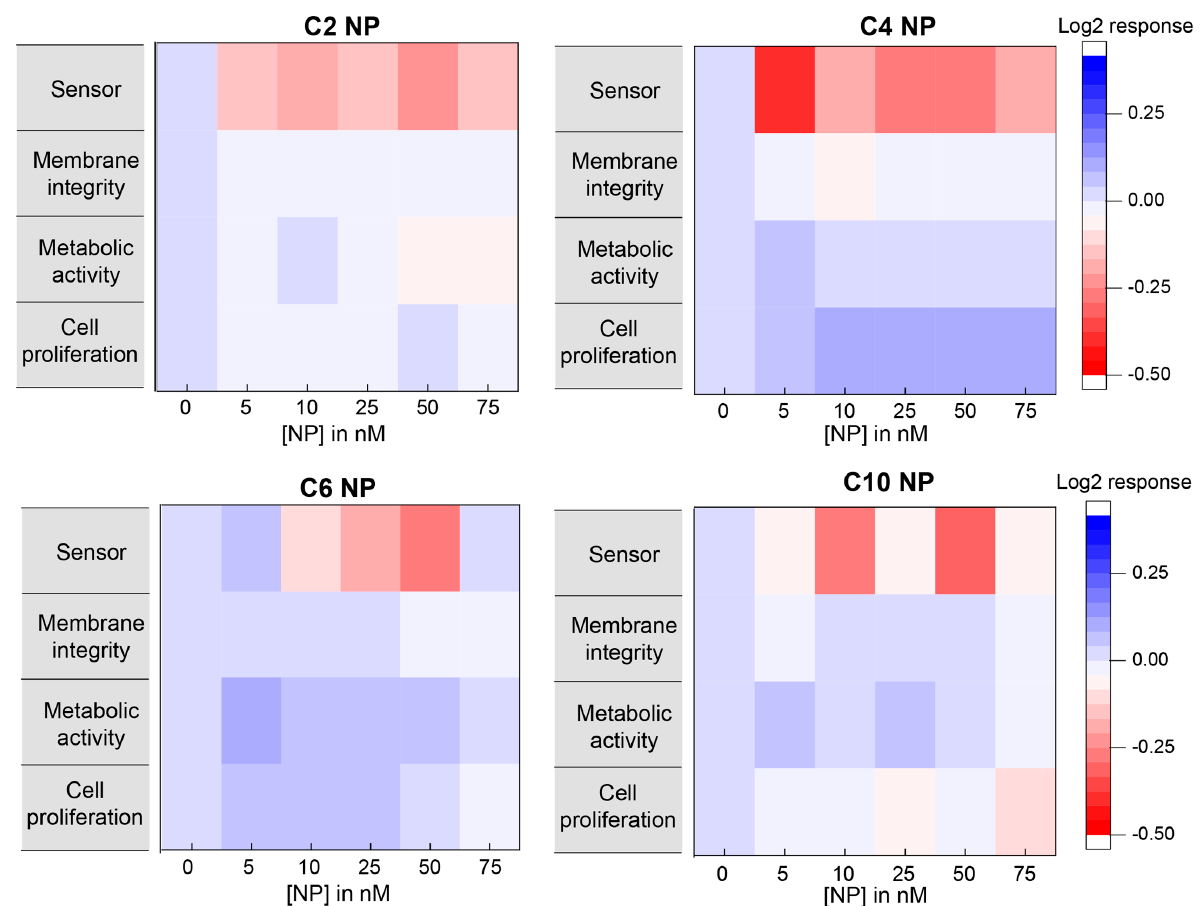
Figure 4. Comparison of MCF10A cellular responses after NPs exposure, as detected by the array- based nanosensor and standard cytotoxicity assays. The cellular responses from the nanosensor showed strong signals when exposed to C2–C10 NPs, whereas weak or null responses were obtained from other cytotoxicity methods. Reproduced with permission from [85]. Copyright 2020